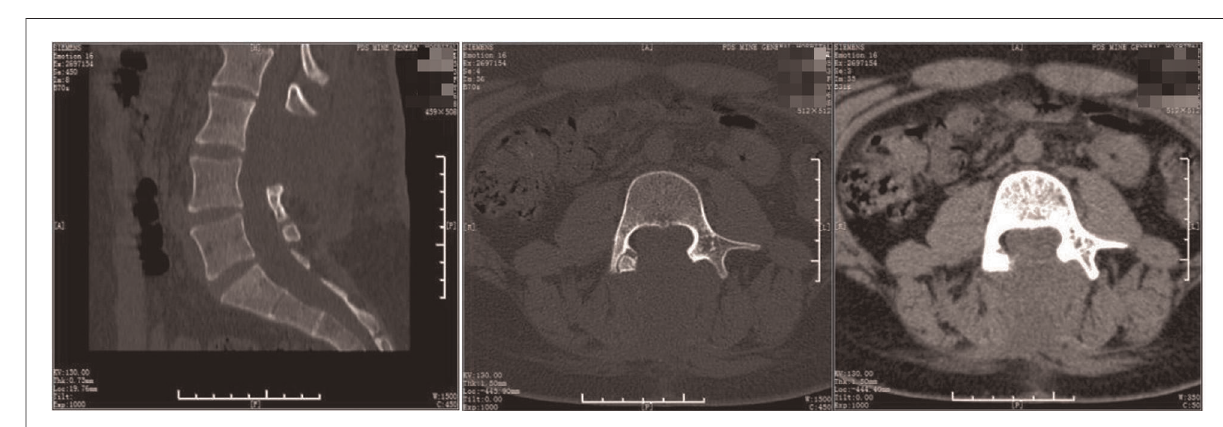
FIGURE 8 Postoperative CT. The spur was excised and the laminae of the L3-5 segments were not